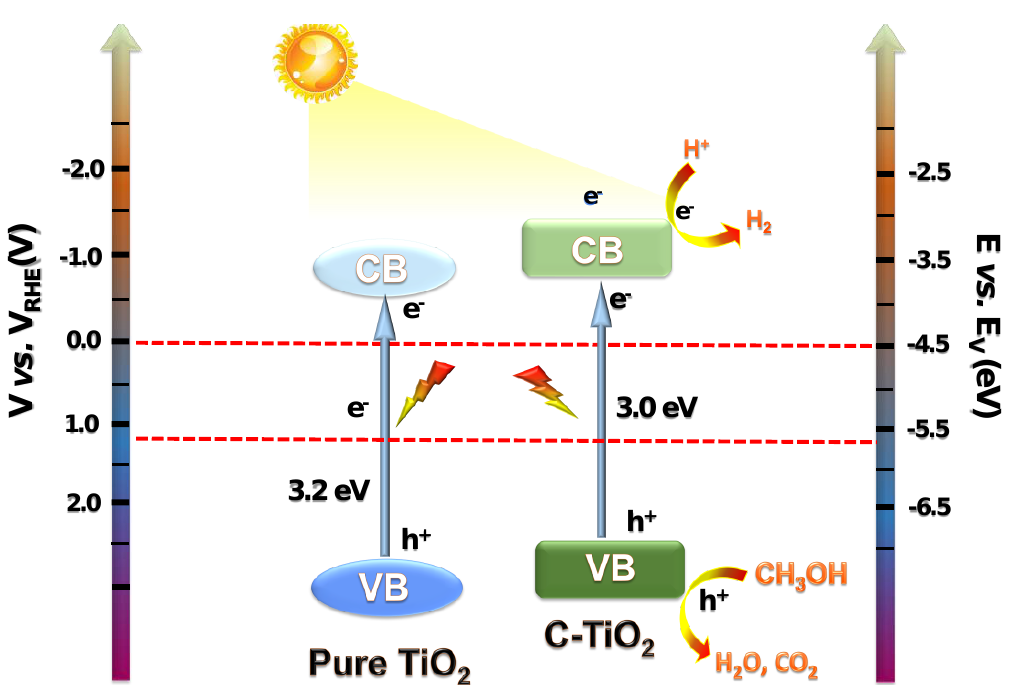
Figure 8. Schematic illustration for the photocatalytic H 2 production mechanism over the C − TiO 2 sample under light irradiation.